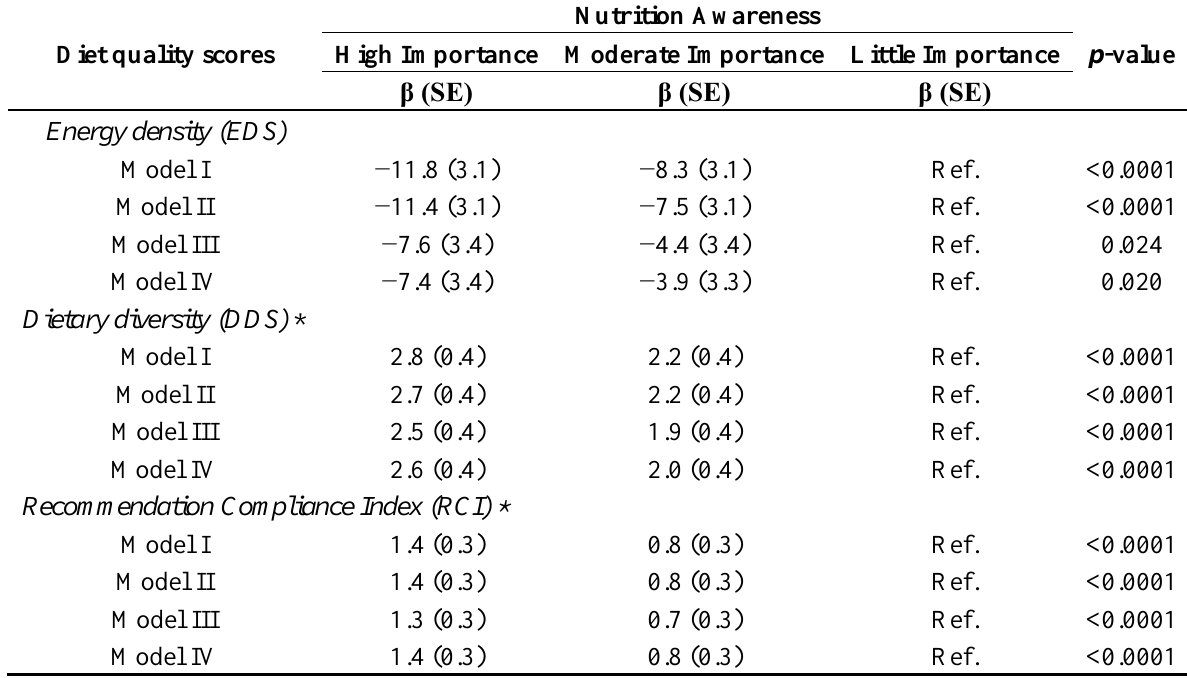
Table 2. Regression coefficients and standard error [ β and (SE)] for the association between nutrition awareness and diet quality scores, ORISCAV-LUX study,